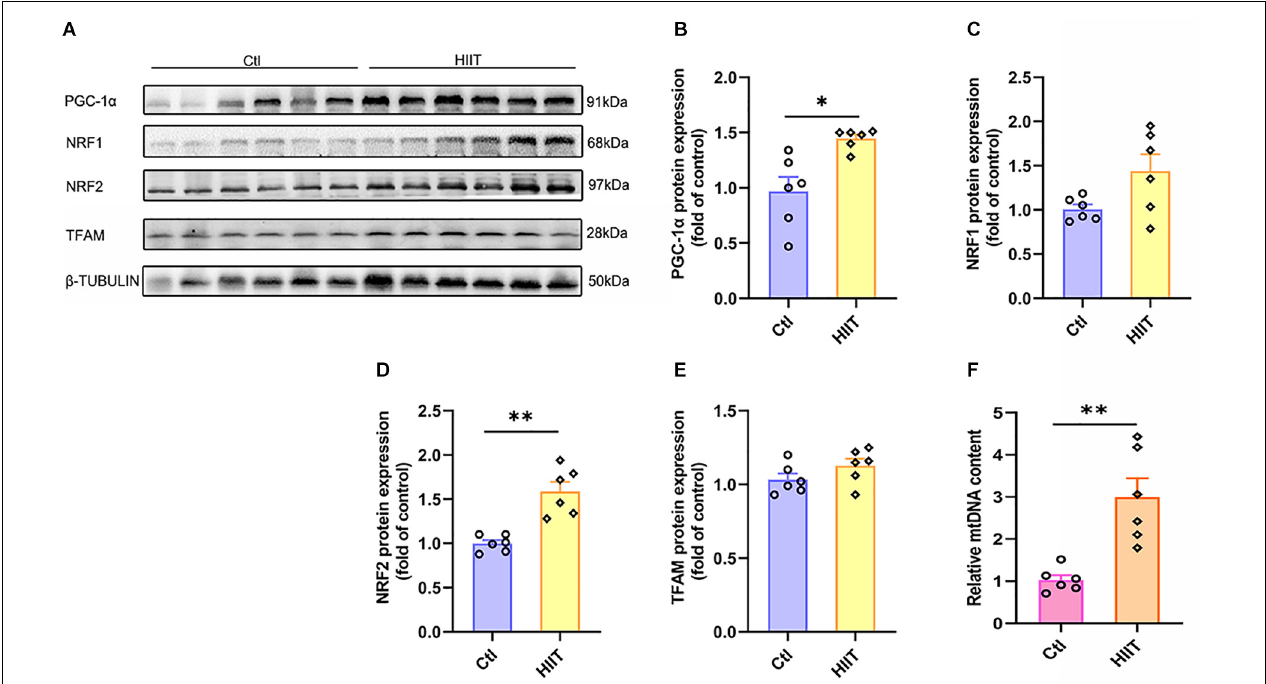
FIGURE 6 | The effects of HIIT on hippocampal mitochondrial biogenesis signal and mitochondria DNA copy number. The peroxisome proliferator-activated receptor γ coactivator-1 α (PGC-1 α ), nuclear respiratory factors 1 (NRF1), nuclear respiratory factors 1 (NRF2), and transcription factor A (TFAM) were determined by WB to evaluate the mitochondrial biogenesis signals in mouse hippocampus. The mt-Cytb level was determined by RT-PCR to evaluate the mitochondria DNA copy number. (A) Representative WB image. (B) PGC-1 α protein expression. (C) NRF1 protein expression. (D) NRF2 protein expression. (E) TFAM protein expression. (F) mt-Cytb level. TUBULIN and Cycs as the loading control. N = 6 mice per group. ∗ p ≤ 0.05 and ∗∗ p ≤ 0.01 as compared with the Ctl group by unpaired Students t test. Values are expressed as mean ± standard error of the